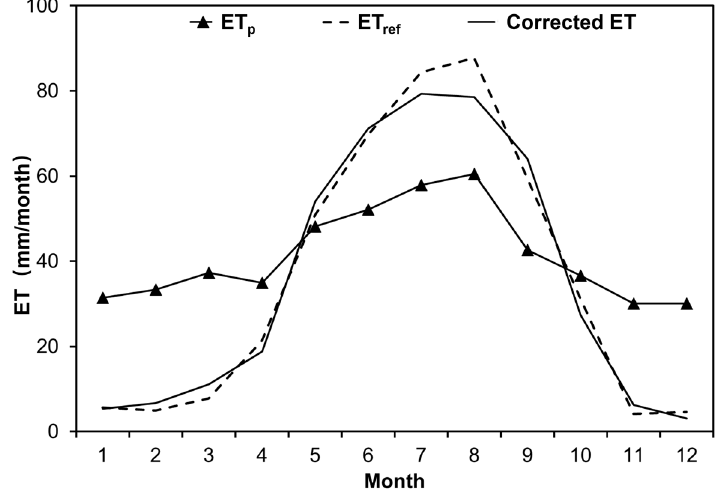
Figure 4. Schematic diagram for monthly ratio correction.